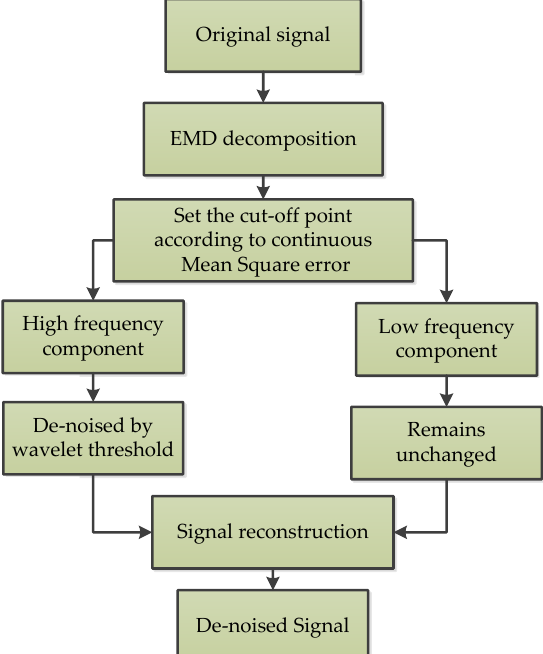
Figure 9. The empirical mode decomposition based wavelet threshold denoising process [51].